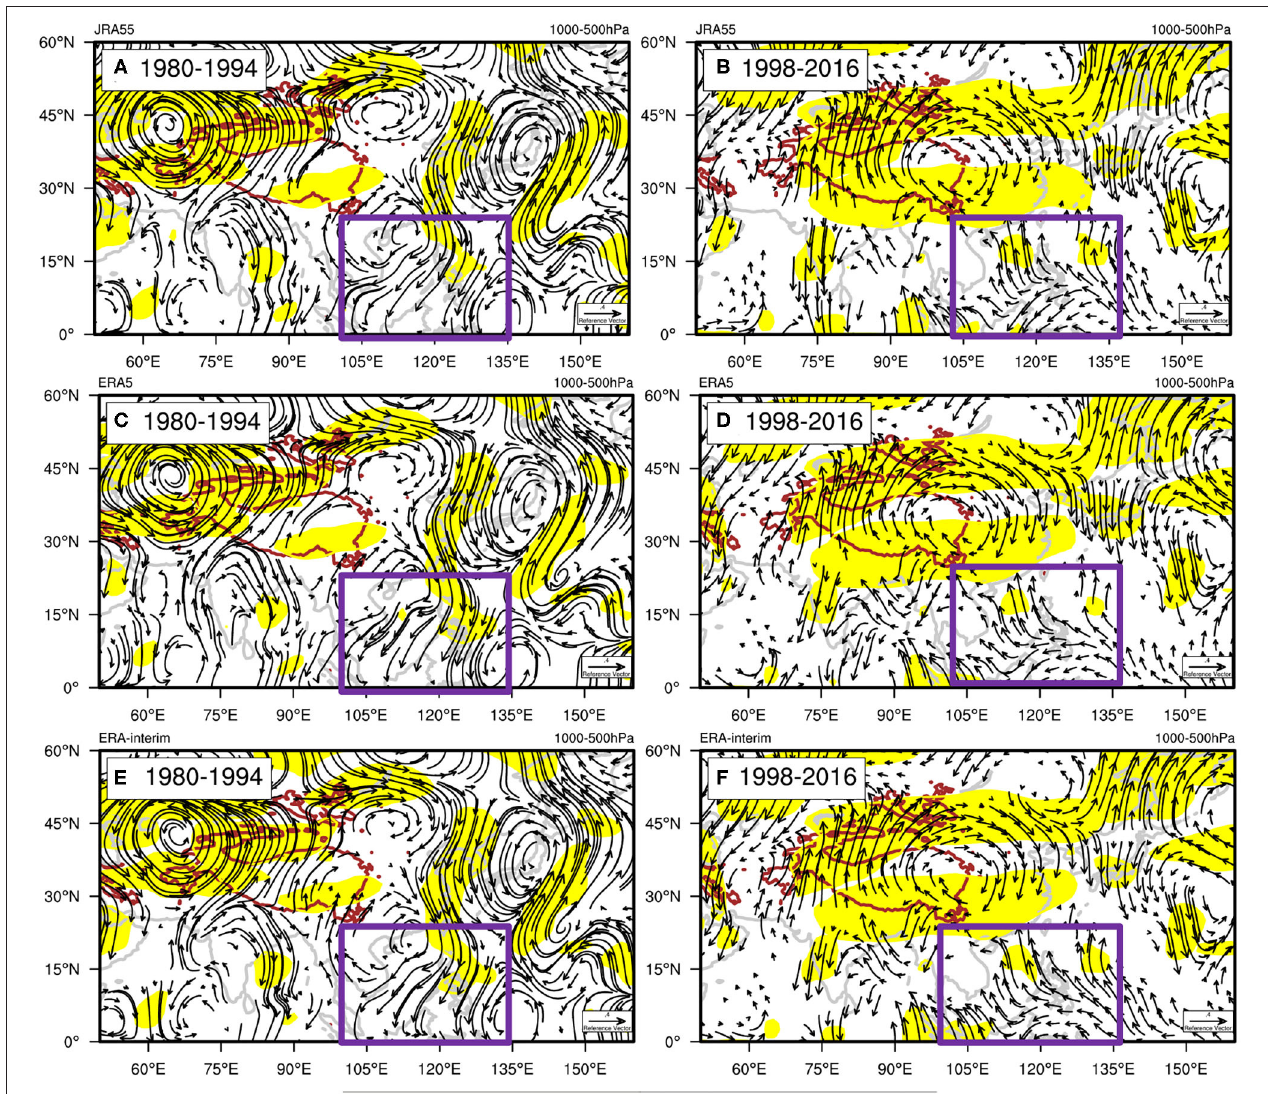
FIGURE 9 | Standardized partial regression coefficients between Tibetan Plateau temperature and vertically integrated moisture flux (VIMF) between 1000–500 hPa in East Asia: (A,C,E) for the period from 1980 to 1994 and (B,D,F) for the period from 1998 to 2016. (A,B) Based on JRA55; (C,D) based on ERA5; and (E,F) based on ERA-Interim. Vectors are ignored for values < 0.15. Shading indicates significant differences above the 90% confidence level based on the Student’s t